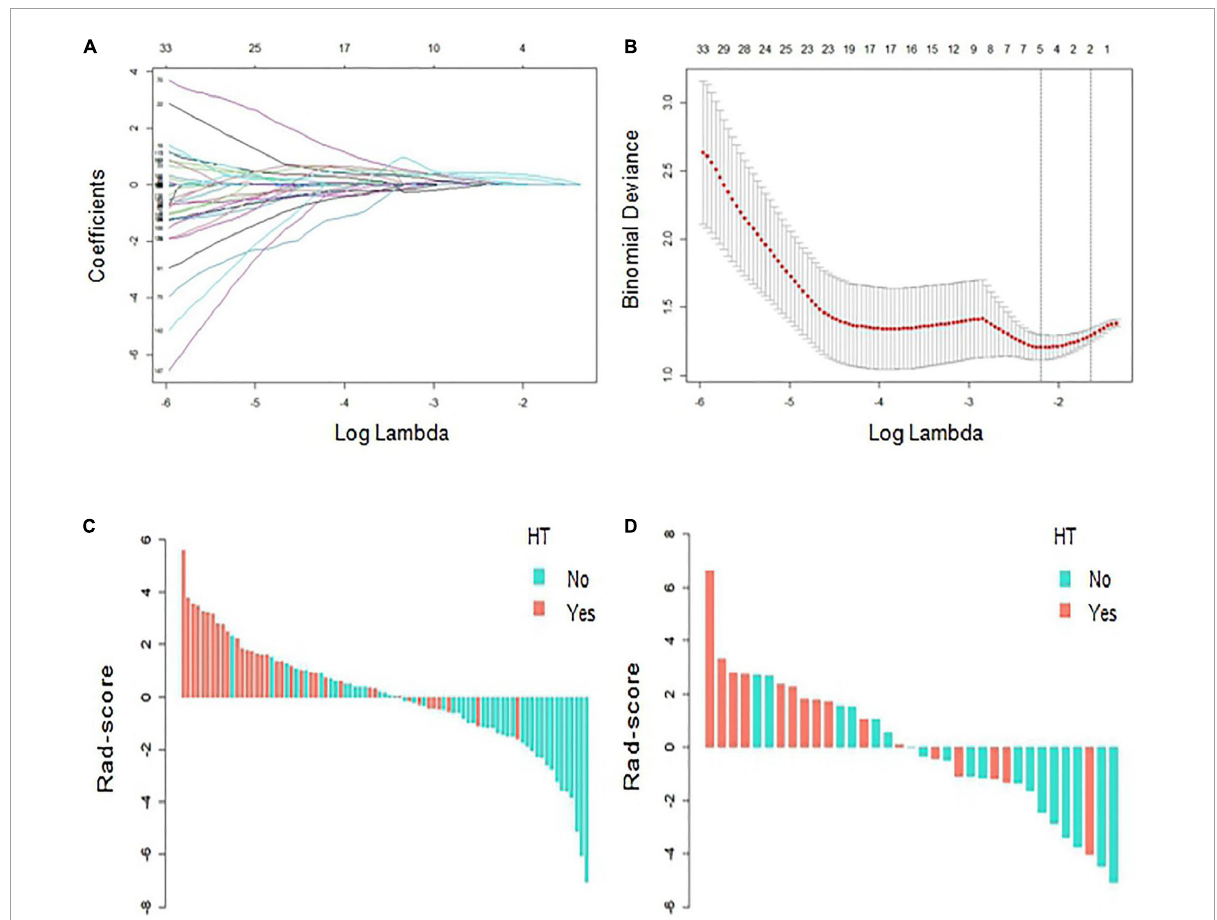
FIGURE3 Radiomics score (Rad-score) development. (A,B) Radiomics feature selection based on least absolute shrinkage and selection operator (LASSO) and 10-fold cross-validation. When binomial deviance is the smallest, a total of five optimal features are obtained. (C,D) The Rad-score of each patient in the training and verification cohorts. Red indicates hemorrhagic transformation (HT), and blue indicates